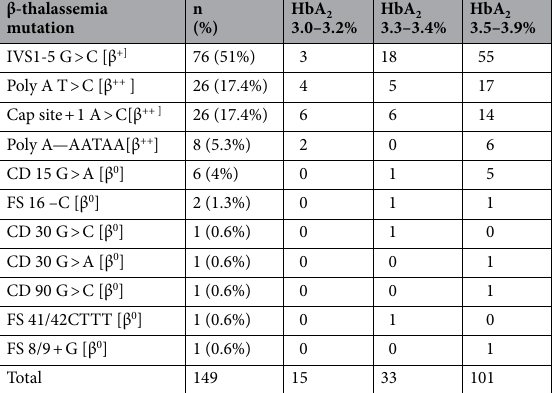
Table 1. Distribution of mutations among borderline HbA 2 β-thalassemia